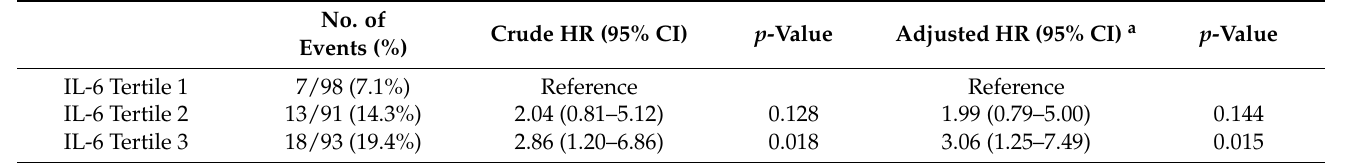
Figure 3. Cumulative survival rate of arteriovenous fistula according to plasma IL-6 tertiles. Abbreviations: AVF, arteriovenous fistula; IL-6, interleukin-6. Table 3. Hazard ratios of plasma IL-6 tertiles for arteriovenous fistula dysfunction.